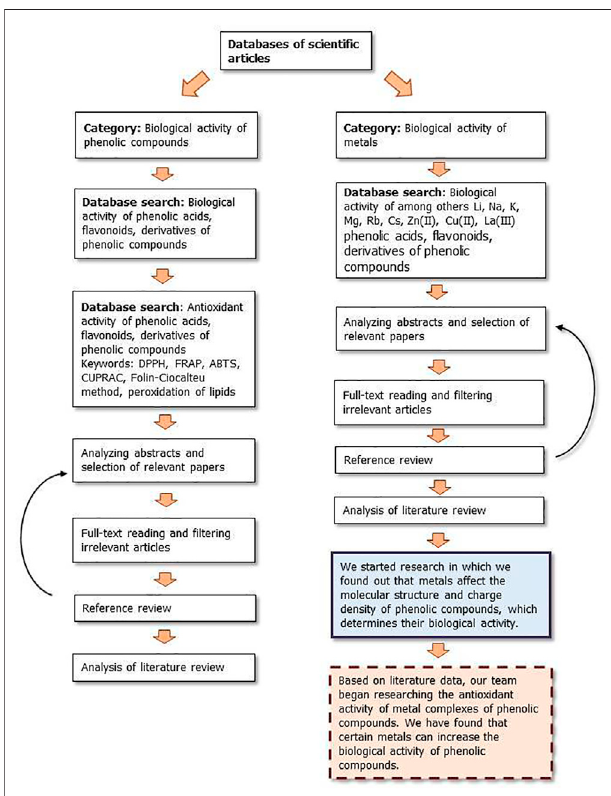
FIGURE 9 | The fl ow diagram which show our strategy for literature survey (part I) based on Ivanov et al. (2019).